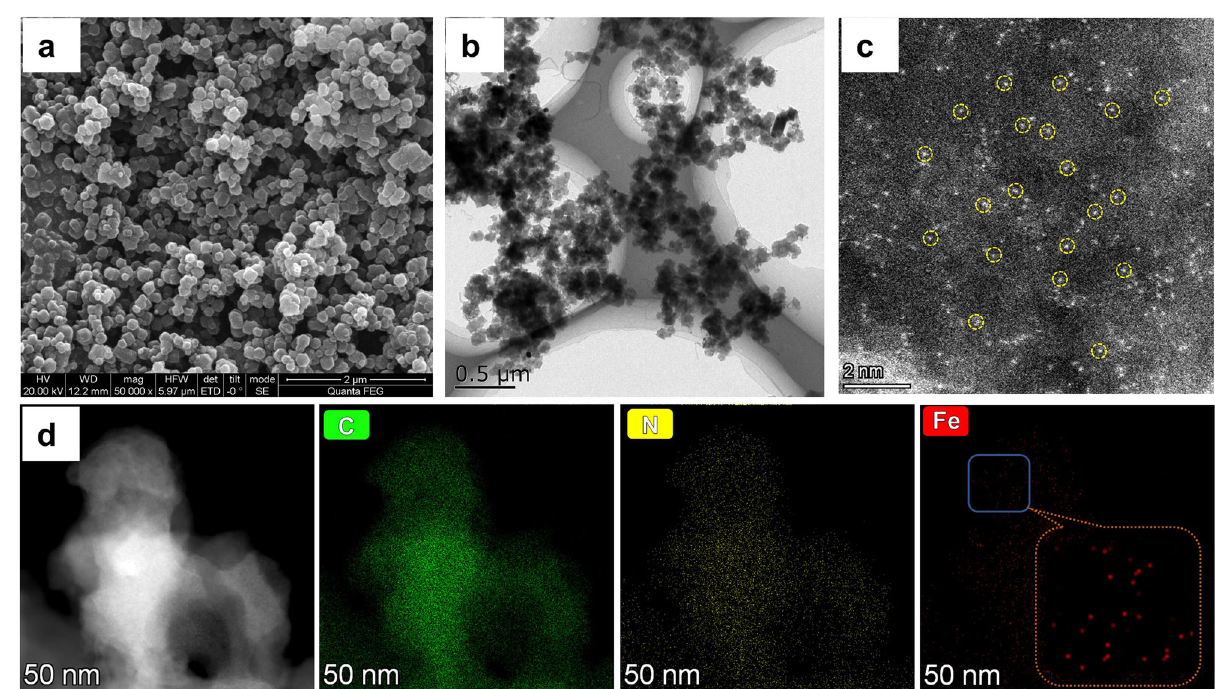
Fig. 3 Representative electron microscopy images. a SEM, b TEM, c HAADFSTEM, d EDS mapping images (C, N, and Fe) of Fe 1 -N-C.